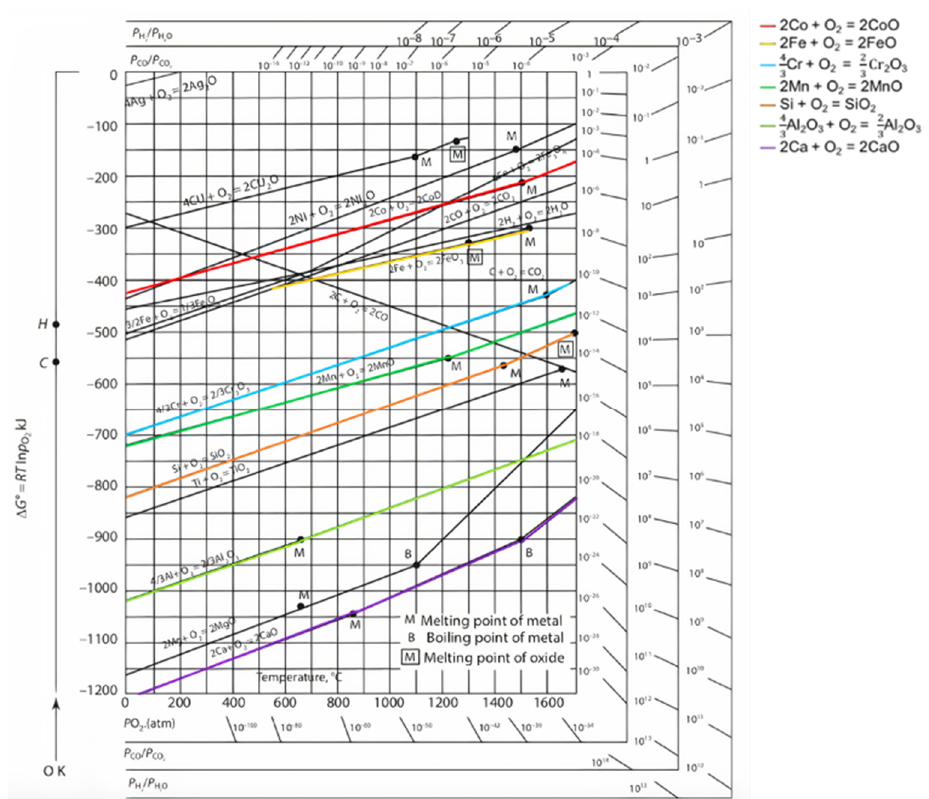
Figure 7. Gibbs free energy in Ellingham diagram [11].